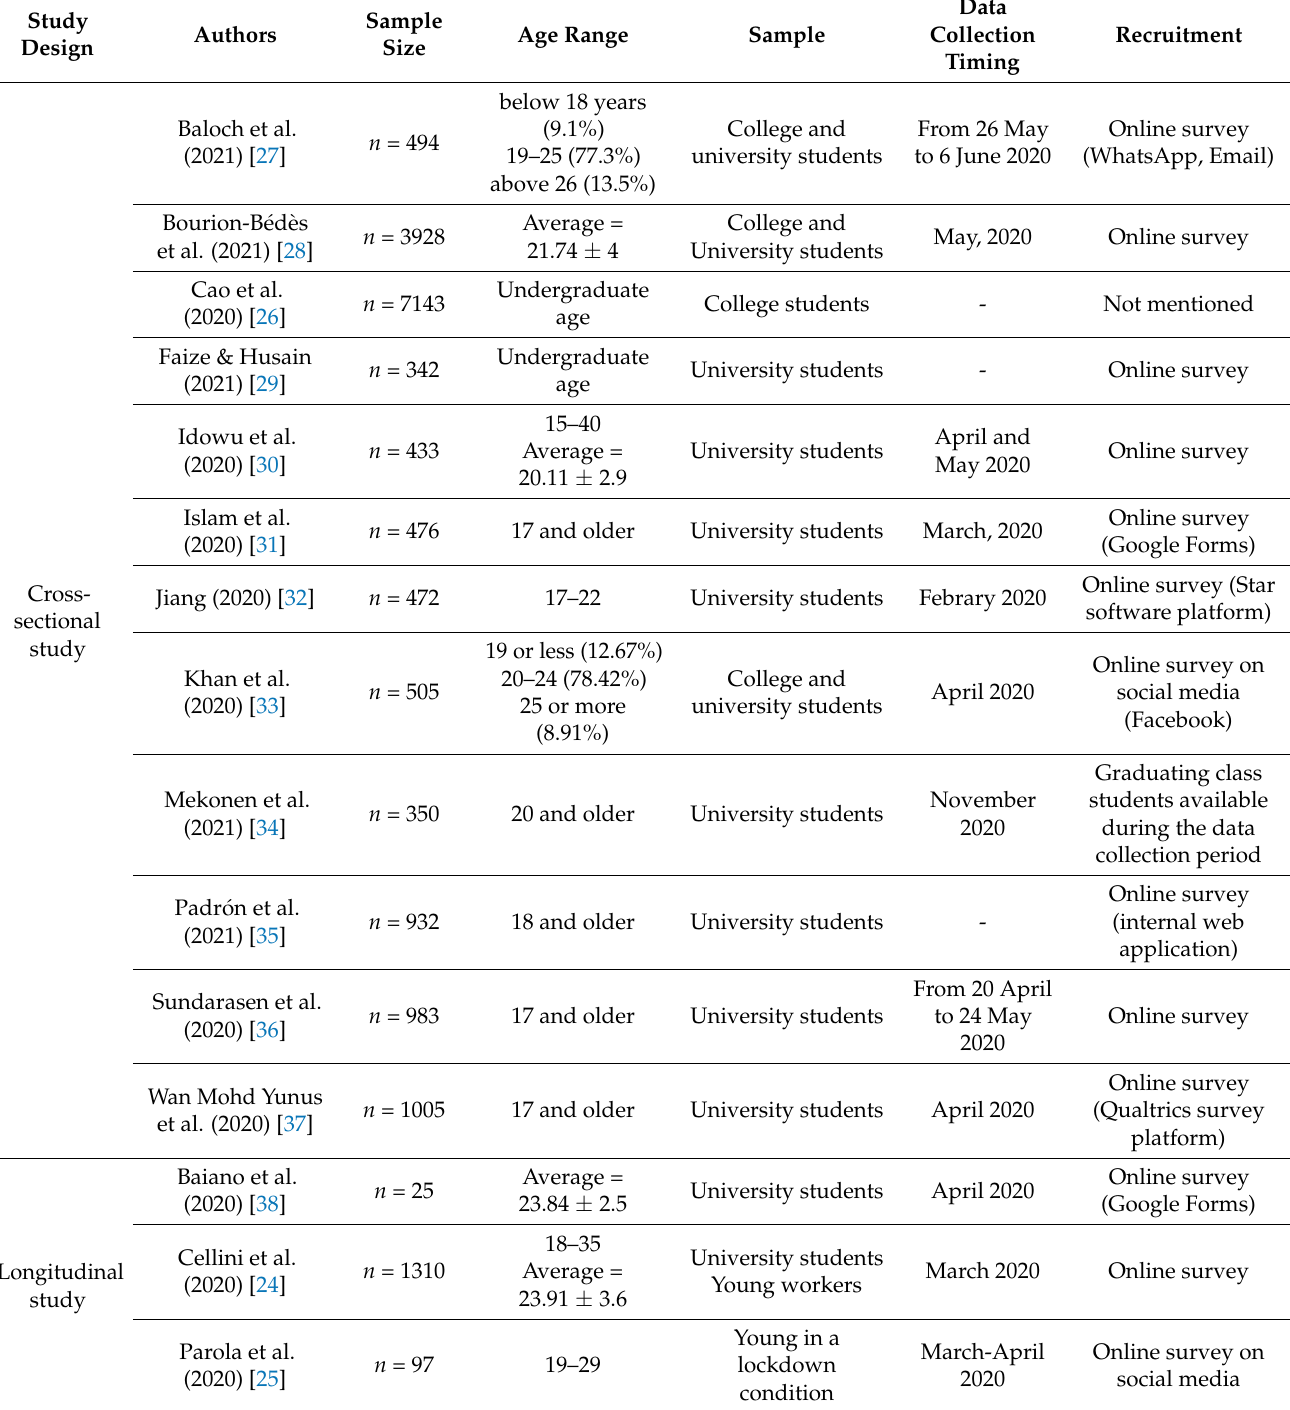
Table 1. Main characteristics of the included